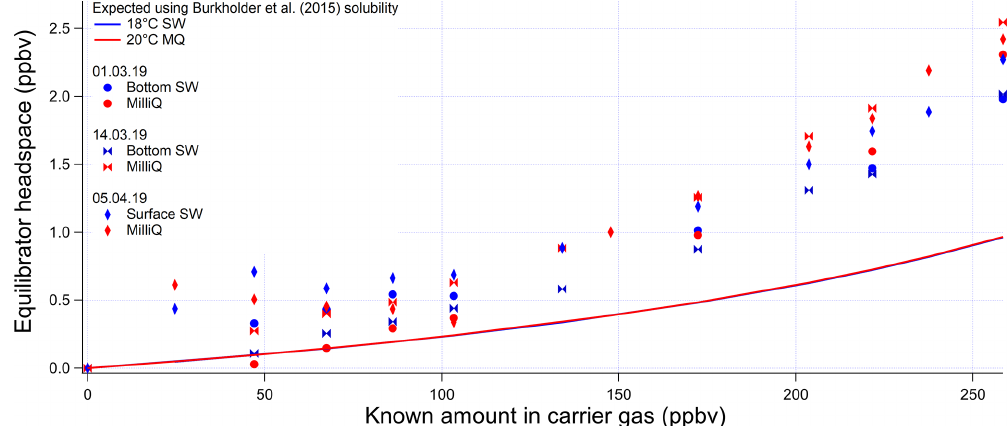
Figure A5. Invasion calibrations for acetaldehyde carried out during the deployment and using different types of water (SW: seawater; MQ: Milli-Q water). Bottom SW refers to seawater collected from well below the mixed layer. Surface SW refers to seawater collected from the ship’s underway seawater inlet. The non-linear response is due to the changing gas flow as more standard gas is added to the zero-air carrier gas, which alters the purging